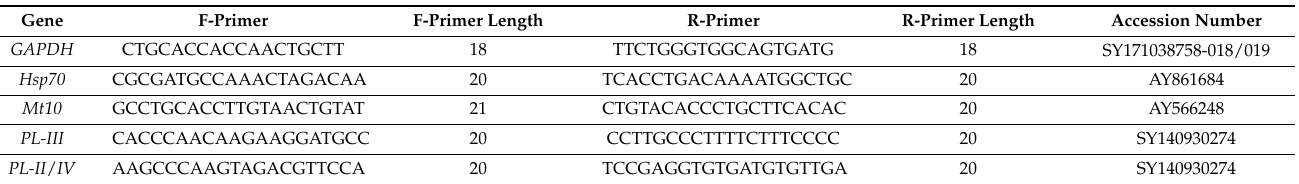
Table 1. List of forward and reverse primers used for amplification of the genes analysed and for GAPDH gene used as housekeeping gene